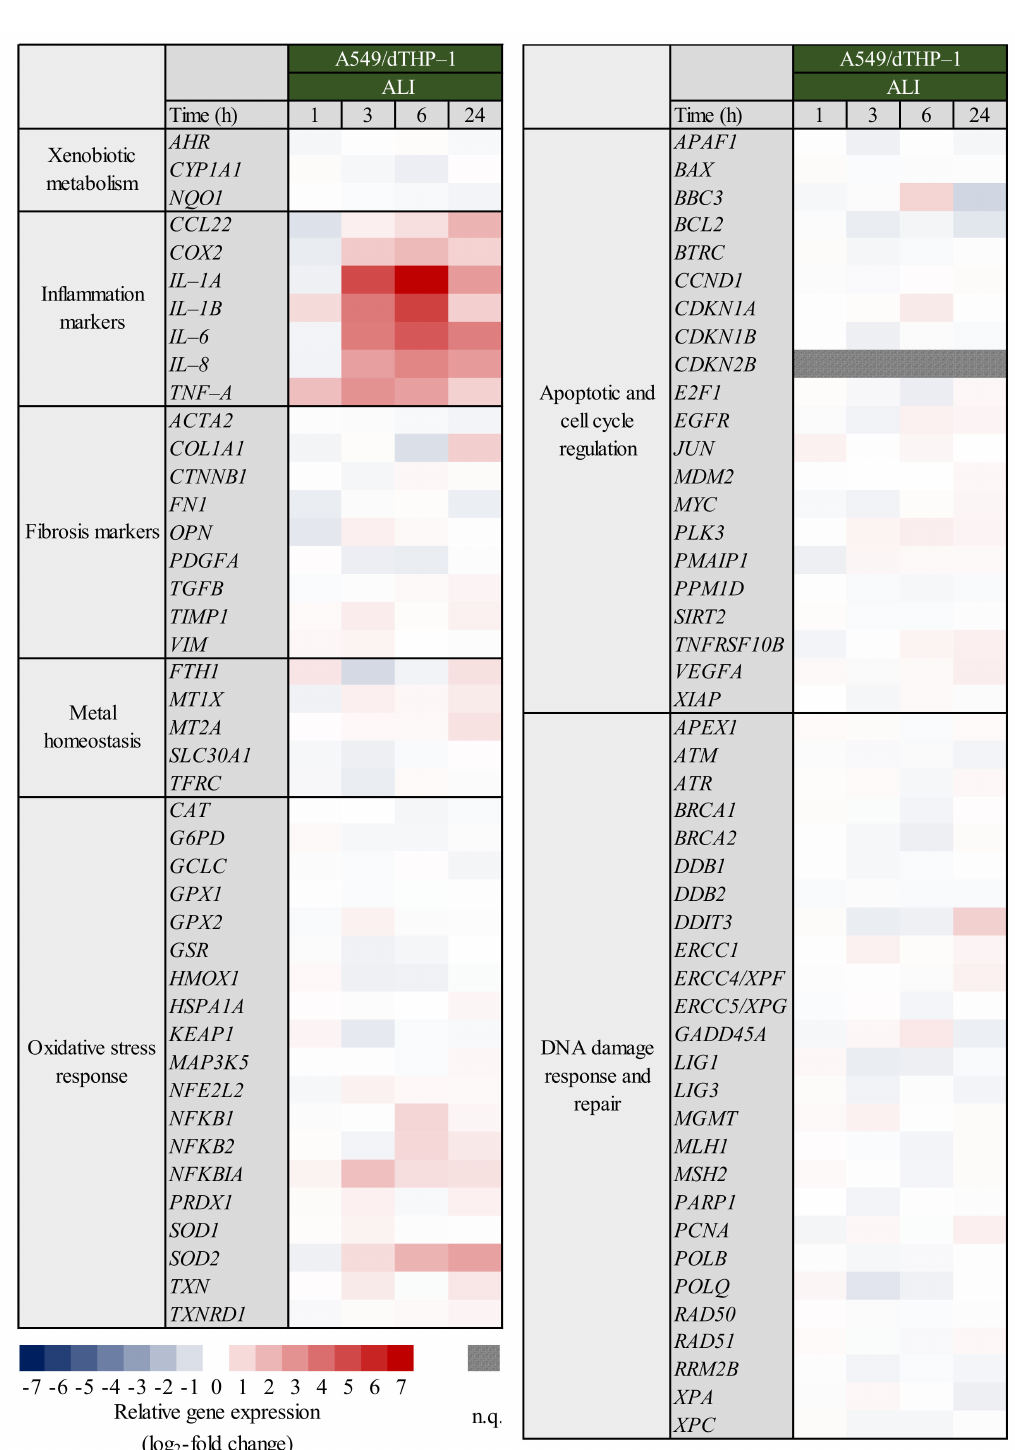
Figure 7. Impact of post-incubation time on Min-U-Sil5 mediated gene expression in A549/dTHP-1 co-cultures after ALI exposure. Co-cultures comprised of A549 and dTHP-1 cells were exposed to 56.9 ± 2.94 µ g/cm 2 of Min-U-Sil5 and incubated for 1, 3, 6 or 24 h. The results are depicted as the log 2 -fold change of the relative gene expression. A red color represents the induction, a blue color the repression of a gene. The means of at least three independent experiments are displayed. Applied doses in ALI exposures were calculated as means ± SD from three independent experiments. n.q.: not quantifiable due to low expression